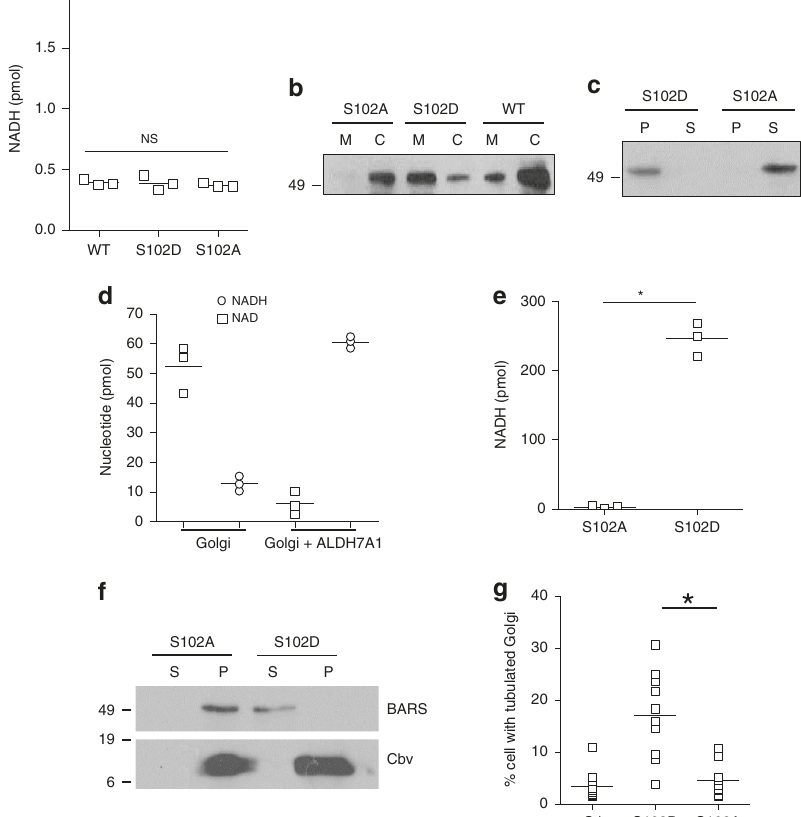
Fig. 10 Phosphorylation of ALDH7A1 regulates its membrane recruitment. Source data are provided as a Source Data fi le. a Recombinant ALDH7A1 was incubated with a known substrate (octanal) and NAD, and the catalytic activity was tracked through the generation of NADH. Mean with standard deviation is shown; NS not signi fi cant, ANOVA; n = 3 independent experiments. b HeLa cells were transfected with different myc-tagged ALDH7A1 constructs as indicated, followed by subcellular fractionation to obtain total cytoplasmic membrane (M) and cytosol (C), and then immunoblotting using anti-myc antibody; n = 2 independent experiments with a representative result shown. c Recombinant forms of ALDH7A1 mutants were incubated with Golgi membrane, followed by centrifugation to obtain membrane (P) vs. soluble (S) fractions, and then immunoblotting for ALDH7A1; n = 2 independent experiments with a representative result shown. d Golgi membrane were treated as indicated, and then the levels of NAD and NADH on the membrane were quanti fi ed; n = 3 independent experiments with a representative result shown. e Liposomes were generated using puri fi ed lipids to mimic the composition of Golgi membrane. A substrate of ALDH7A1 (octanal) and NAD were then added, followed by incubation with different forms of recombinant ALDH7A1 as indicated. The level of NADH was then quanti fi ed. Mean with standard deviation is shown; * p < 0.05, paired two-tailed Student ’ s t -test; n = 3 independent experiments. f Golgi membrane was incubated with mutant forms of ALDH7A1 as indicated, followed by centrifugation to re-isolate Golgi membrane (P, pellet) vs. soluble (S) fraction. Both fractions were then immunoblotted for endogenous BARS; n = 2 independent experiments with a representative result shown. g HeLa cells that expressed the different mutant forms of ALDH7A1 as indicated, achieved by siRNA against endogenous ALDH7A1 followed by transfection of mutant forms, were examined by immuno fl uorescence microscopy that tracked VSVG leaving the TGN. Cells that showed VSVG-positive Golgi tubules were then quanti fi ed; n = 3 independent